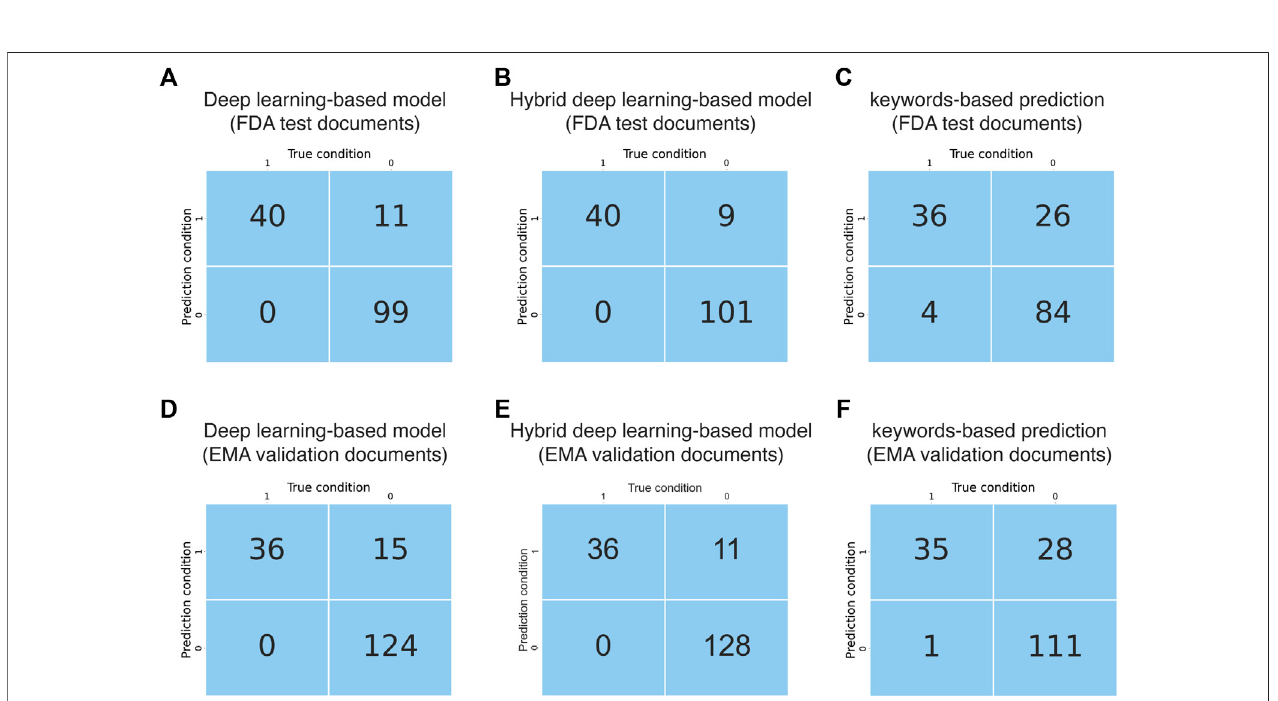
Model validation using cross-agency data (EMA test documents) Document classi fi cation models